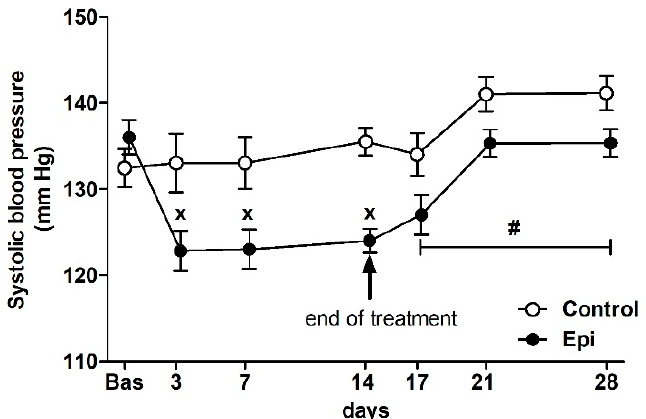
Figure 1. The e ff ect of (–)-epicatechin on the systolic blood pressure of borderline hypertensive rats. The values represent the mean ± SEM. x p < 0.05 vs. control group on the respective day of experiment, # p < 0.03 vs. control group (ANOVA main e ff ect of group during post-treatment period i.e., on days 17, 21 and 28, see Results). Abbreviations. Bas: baseline value, Epi: (–)-epicatechin group.